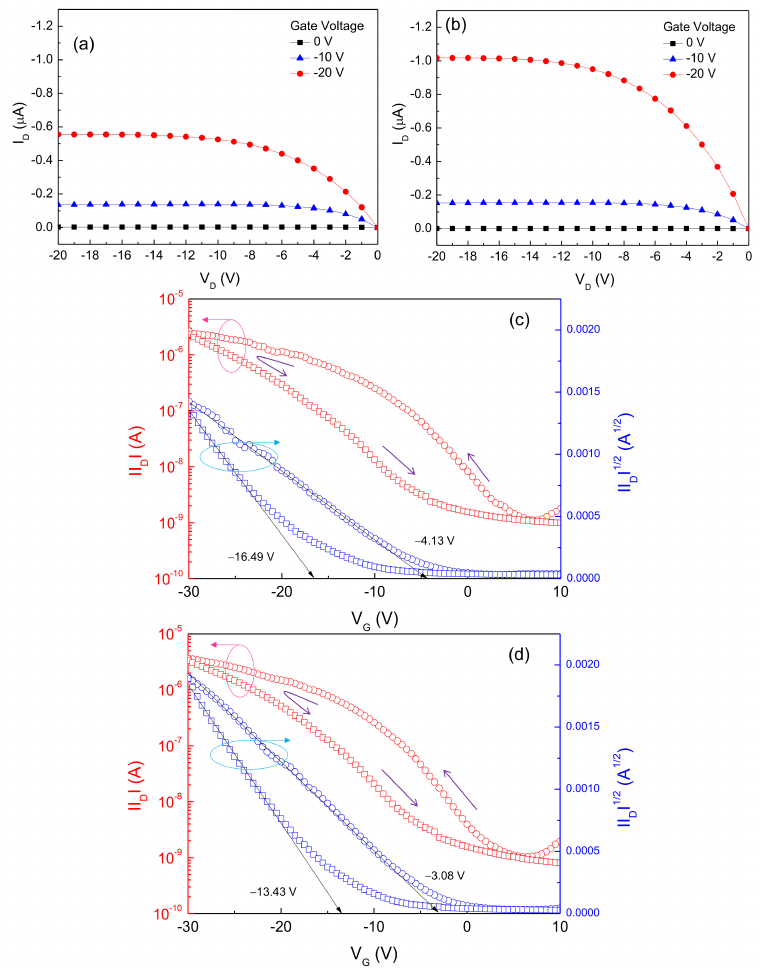
Figure 8. Output characteristics (I D versus V D plots) of the CuO TFT ( a ) before and ( b ) after iodine doping. Transfer characteristics of the CuO TFT (|I D | and |I D | 1/2 versus V G plots) ( c ) before and ( d ) after iodine